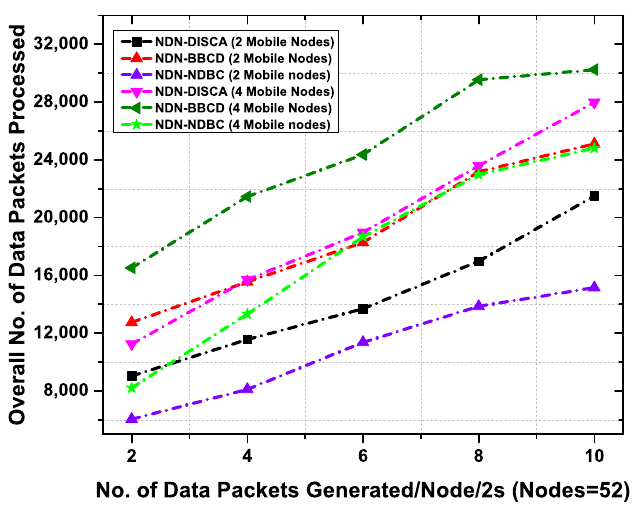
Figure 8. Overall number of data packets processed as a function of number of data packets generated per 2 s with 48 static nodes and (2–4) mobile